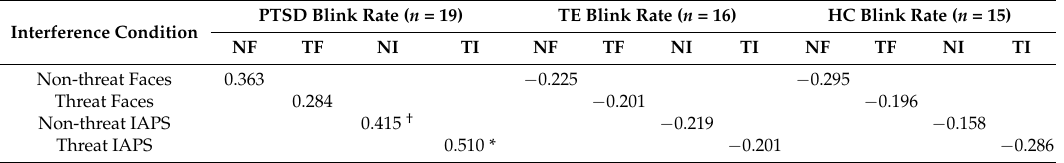
Table 2. Correlation coefficients between sEBR and inhibitory control scores (incongruent RT minus congruent RT) for PTSD, TE, and healthy control participants in each of four conditions: threat faces, non-threat faces, threat IAPS, and non-threat